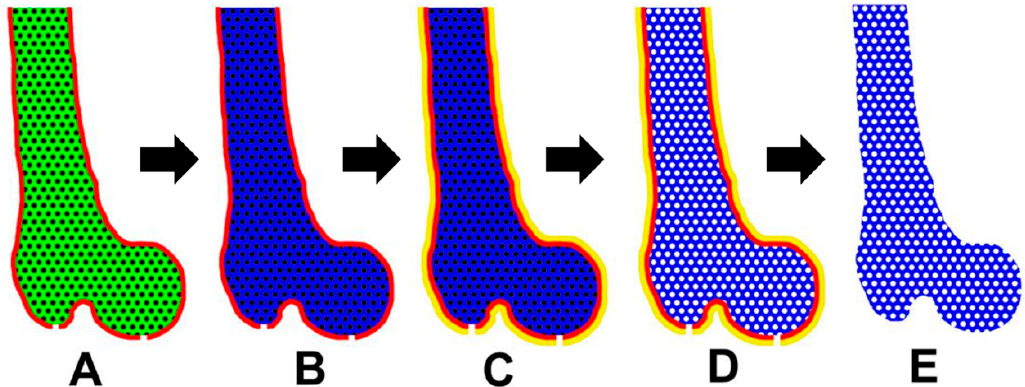
Figure 11. Schematics of the workflow. ( A ) The PLA polymer was dissolved in dichloromethane (green indicates the PLA solution) and mixed with NaCl (black) and loaded into the PVA mold (red). ( B ) The dichloromethane was removed by perfusing with 100% ethanol (blue indicates the solid PLA). ( C ) A 3D printed mold using acrylonitrile butadiene styrene (ABS, yellow) was added to cover the original PVA mold. ( D ) NaCl porogens were removed by perfusing with water. ( E ) An anatomically-shaped scaffold was generated after removing the ABS and PVA molds (white indicates the pores). A 70 mm long × 10 mm diameter 3D printed PVA cylindrical mold was used to generate a